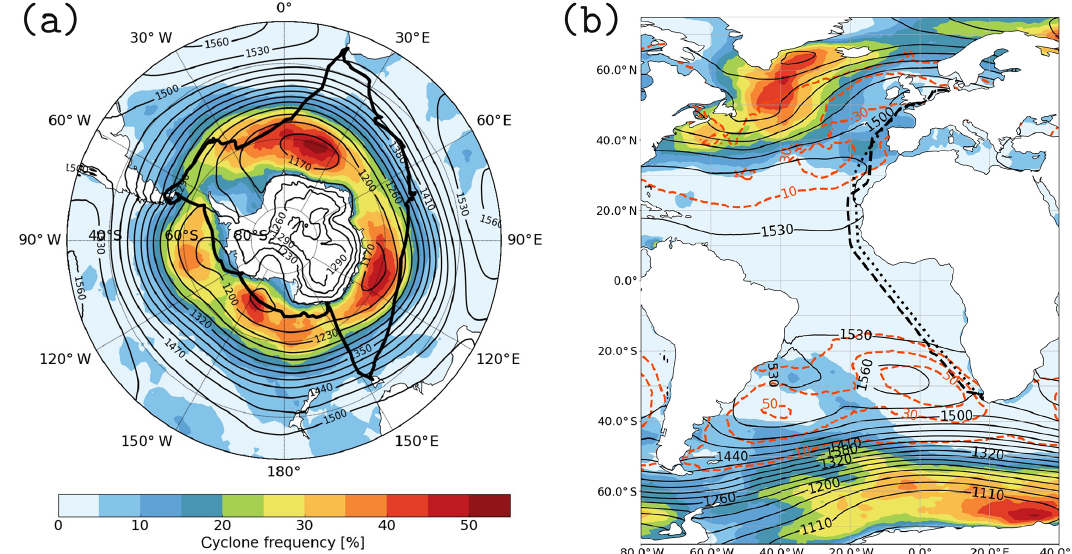
Figure 9. Mean cyclone frequencies (coloured contours, %) and geopotential height at 850hPa (black contours, metres) are shown for legs 1–3 (a) and legs 0 and 4 (b) . The mean anticyclone frequencies (orange, dashed contours, %) for legs 0 and 4 are additionally plotted in panel (b) . The thick black line shows the ship tracks for legs 1–3. The dashed and dotted black lines show the ship track of legs 0 and 4, respectively. ECMWF operational analysis data were used to produce this